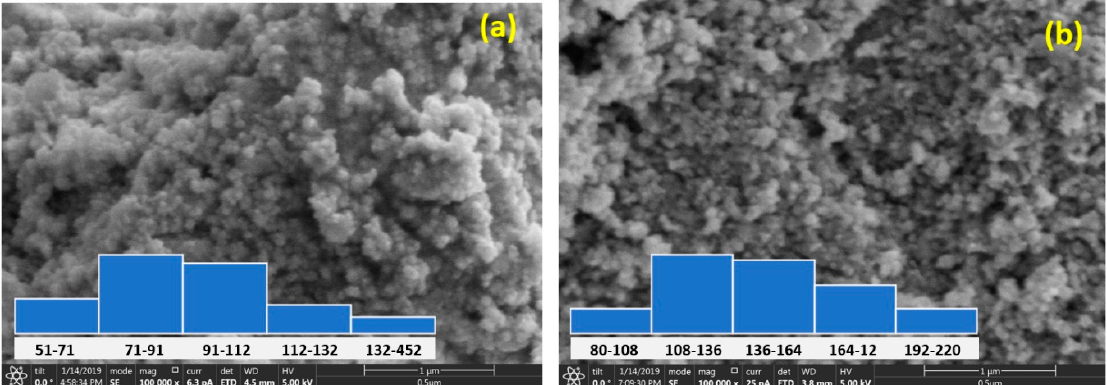
Figure 3. FESEM of Sr-CoFe 2 O 4 nanoparticles ( a ) with calcination temperature 300 °C ( b ) with calcination temperature 400 °C.